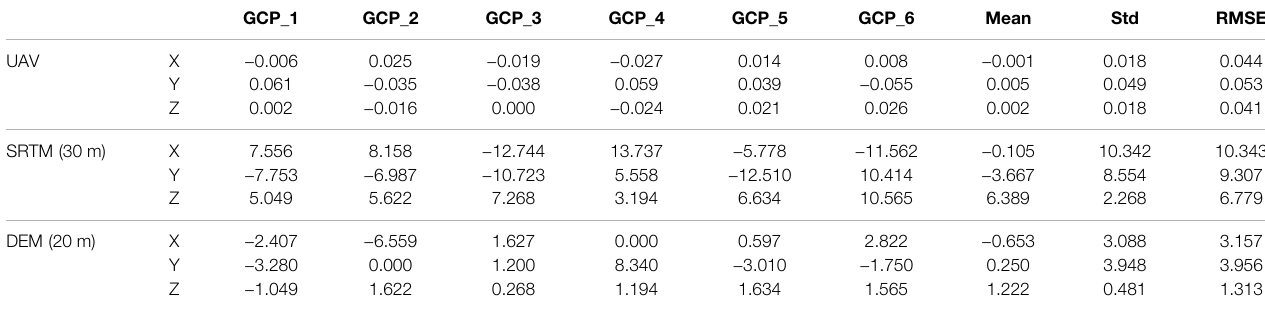
TABLE 2 | Accuracy of the ground control points